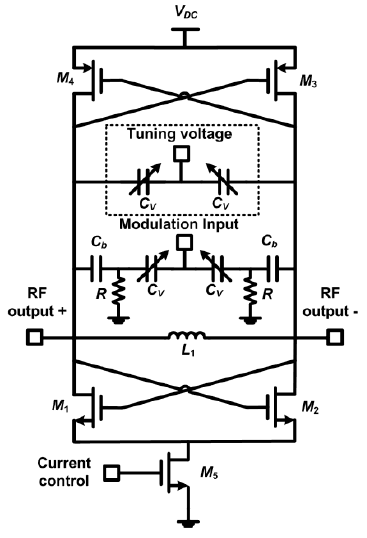
Figure 2. Basic schematic of the direct-modulation transmitter. The set of varactors shown within the dashed lines were only implemented in the 433 MHz design. Inductor L in the 433 MHz design and 2.3 nH in the 2.4 GHz